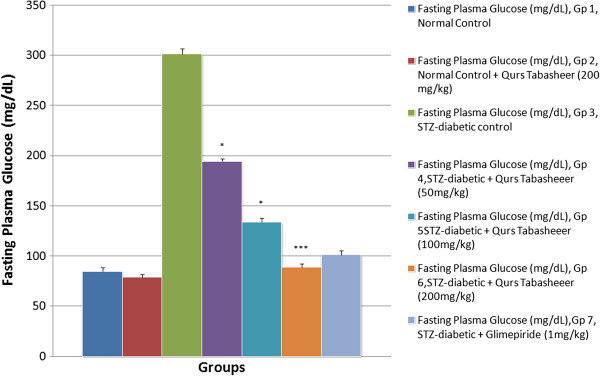
Effect of Qurs Tabasheer on glycemic control at different concentrations on normal and STZ induced diabetic rats, compared to standard drug Glimepiride; values are mean ± SEM; n = 6; *P < 0.05; **P < 0.01; ***P < 0.001; P > 0.05 is considered as non-significant (ns).